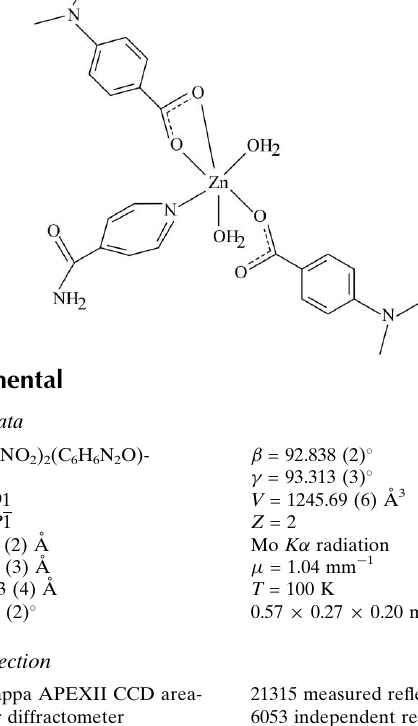
Data collection Bruker Kappa APEXII CCD area- detector diffractometer